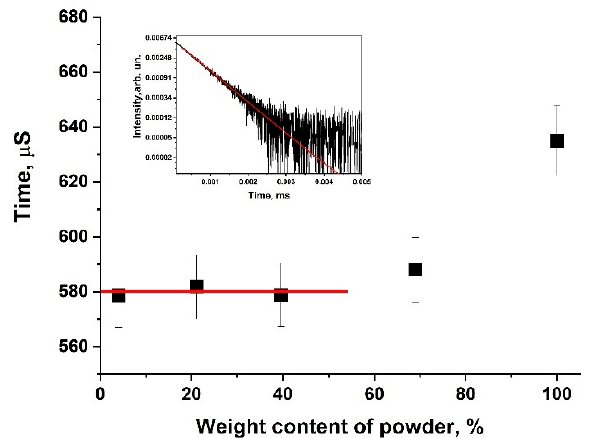
Figure 8. The 2 F 5/2 energy level lifetimes of Yb: YMBO crystal. The inset shows the kinetics of luminescence decay from 2 F 5/2 energy level of Yb 3+ ions.